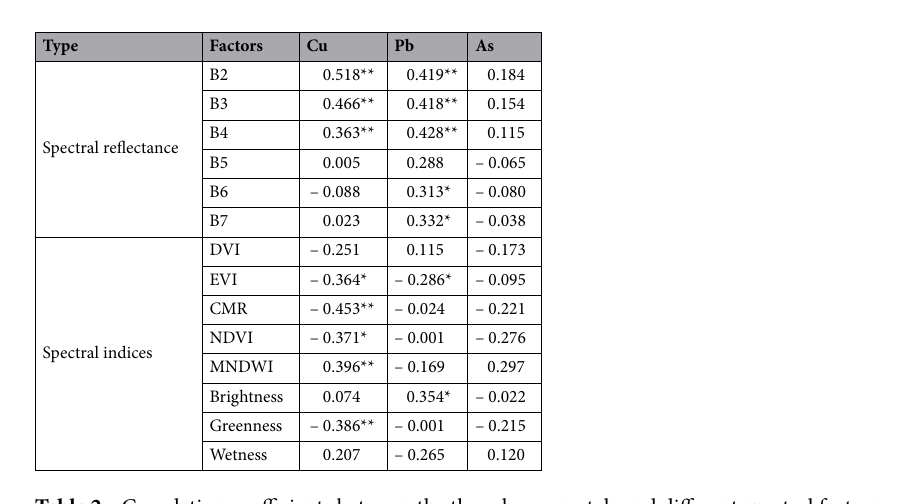
Table 2. Correlation coefficients between the three heavy metals and different spectral